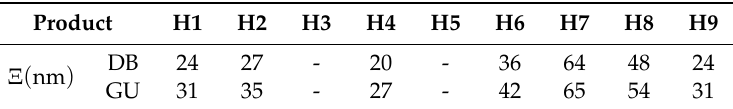
Figure 13. Measured excess Rayleigh ratio for different polyacrylamide hydrogels and the correspondent data fitting using the Debye-Bueche and Guinier functions. ( a ) H1, ( b ) H2, ( c ) H6, and ( d ) H9. Table 5. Correlation length ( Ξ in nm) for di ff erent kinds of products estimated through static light scattering measurements and using di ff erent models for data analysis, namely the Debye-Bueche (DB) and the Guinier (GU)